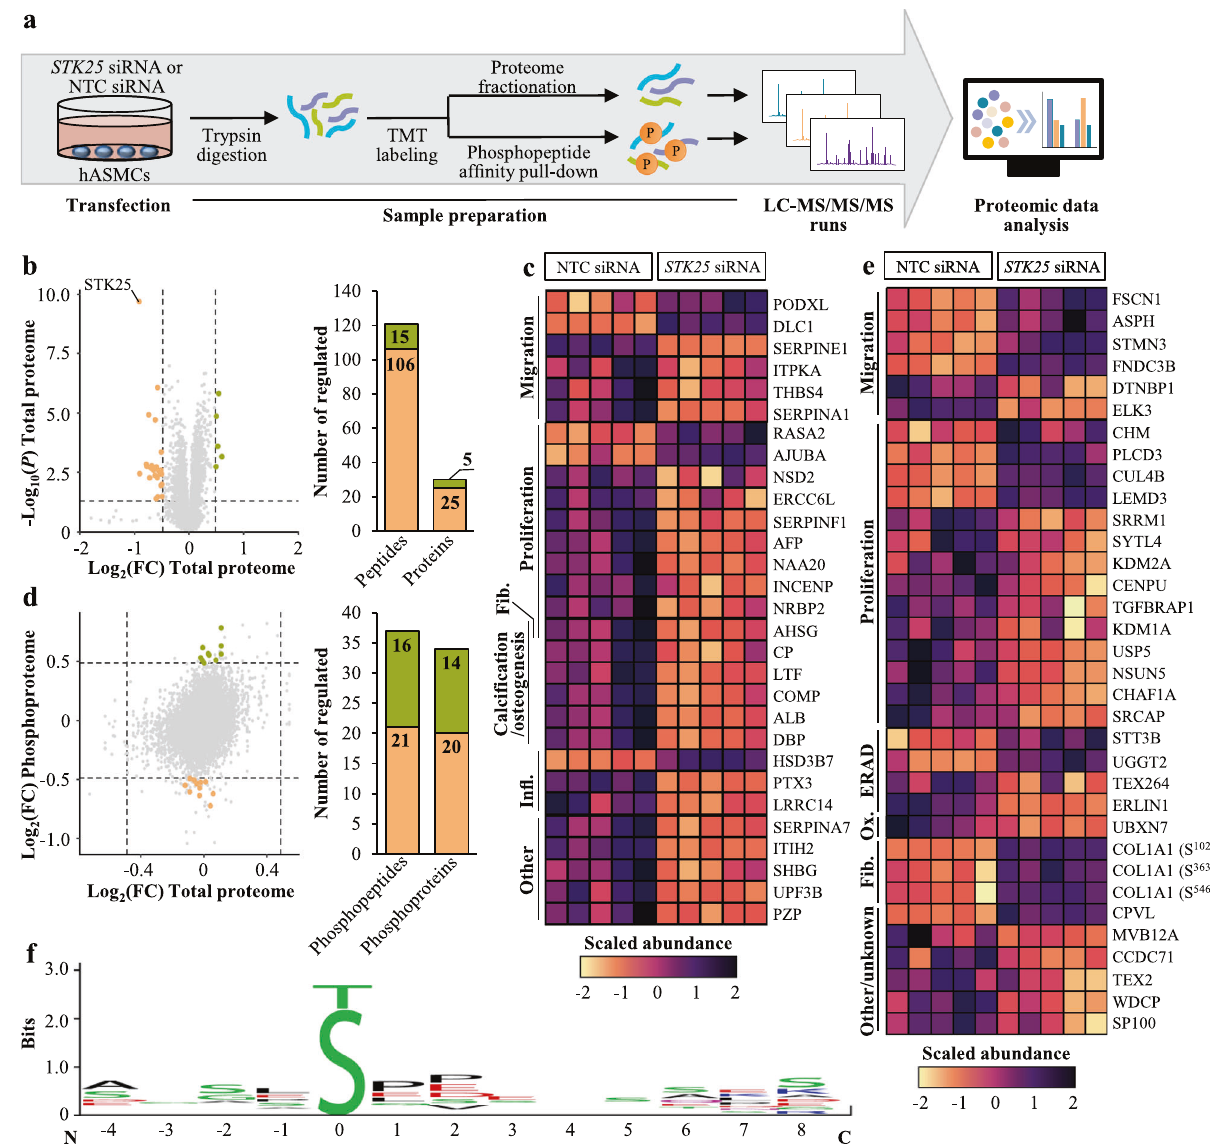
Fig. 7 Global proteomics and phosphoproteomic analysis in human aortic smooth muscle cells. hASMCs were transfected with STK25 siRNA or NTC siRNA. a Schematic presentation of the experimental design. b Volcano plot of the log-transformed fold change and signi fi cance of differentially enriched proteins. A ratio of 1.4-fold (vertical dashed lines) and a P value of 0.05 (horizontal dashed line) serve as the threshold for differential expression. Stacked bar plot showing the total number of differentially expressed unique peptides and proteins. c Heat map of the scaled abundance of signi fi cantly changed proteins. The functions are indicated to the left. d Scatter plot of the log-transformed fold change of total protein abundance and the log-transformed fold change of phosphoproteins. Stacked bar plot showing the total number of differentially expressed unique phosphopeptides and phosphoproteins that were not driven by underlying changes in the abundance of corresponding proteins. A ratio of 1.4-fold (vertical and horizontal dashed lines) and a P value of 0.05 serve as the threshold for differential expression. e Heat map of the scaled abundance of signi fi cantly changed phosphoproteins. The functions are indicated to the left. f Consensus sequences were extracted from the peptides with downregulated phosphorylation events in STK25-depleted hASMCs using the WebLogo application 37 . The residue position in relation to the phosphorylation site is shown on the X-axis and the information content is shown on the Y-axis, where the height of each position is representing the certainty level of possibly presented residues in that position. For empty positions, there were not enough information to determine its composition. The colors of the amino acids correspond to their chemical properties; polar amino acids (G, S, T, Y, C, Q, and N) are shown in green, basic amino acids (K, R, and H) are shown in blue, acidic amino acids (D and E) are shown in red, and hydrophobic amino acids (A, V, L, I, P, W, F, and M) are shown in black. FC, fold change; Fib., fi brosis; In fl ., in fl ammation; Ox., oxidative the labeling solution, the cells were fi xed, blocked and incubated with peroxidase Adherent monocytes were quanti fi ed in 6 randomly selected microscopic fi elds labeled anti-BrdU solution, followed by incubation with TMB substrate. The (×20) using the ImageJ software. reaction was stopped with 1mol/l sulphuric acid and the absorbance was measured using the SpectraMax iD3 Multi-Mode Microplate Reader (Molecular Devices). Cell proliferation . Proliferation was measured using the BrdU-Labeling Assay Kit (Amersham Cell Proliferation Biotrak ELISA System, version 2, RPN250; GE Migration . Primary hASMCs and hAECs were added to transwell chambers with Healthcare, Chicago, IL) according to the manufacturer ’ s recommendations. 8 µm pore size (Nunc Polycarbonate Cell Culture Inserts in Multi-Well Plates; Brie fl y, cells were incubated with BrdU-labeling solution for 2 h. After removing